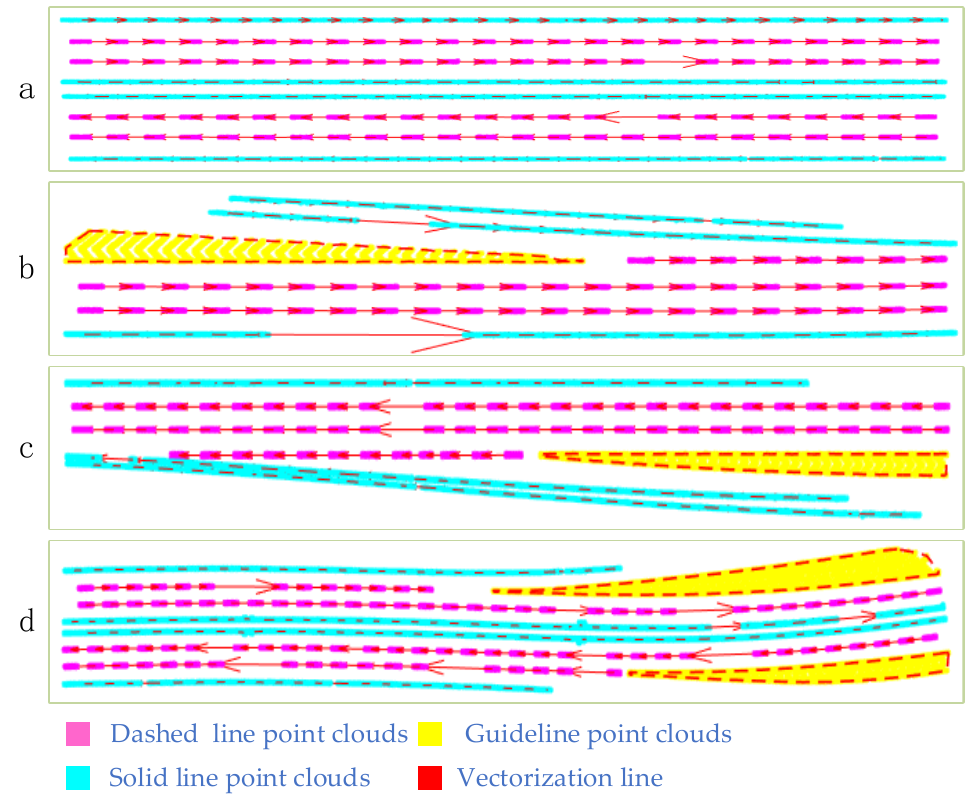
Figure 18. Road markings vectorization for dashed lines and solid lines. ( a ) The result of vectorization of Figure 17a; ( b ) The result of vectorization of Figure 17b; ( c ) The result of vectorization of Figure 17c; ( d ) The result of vectorization of Figure 17d.